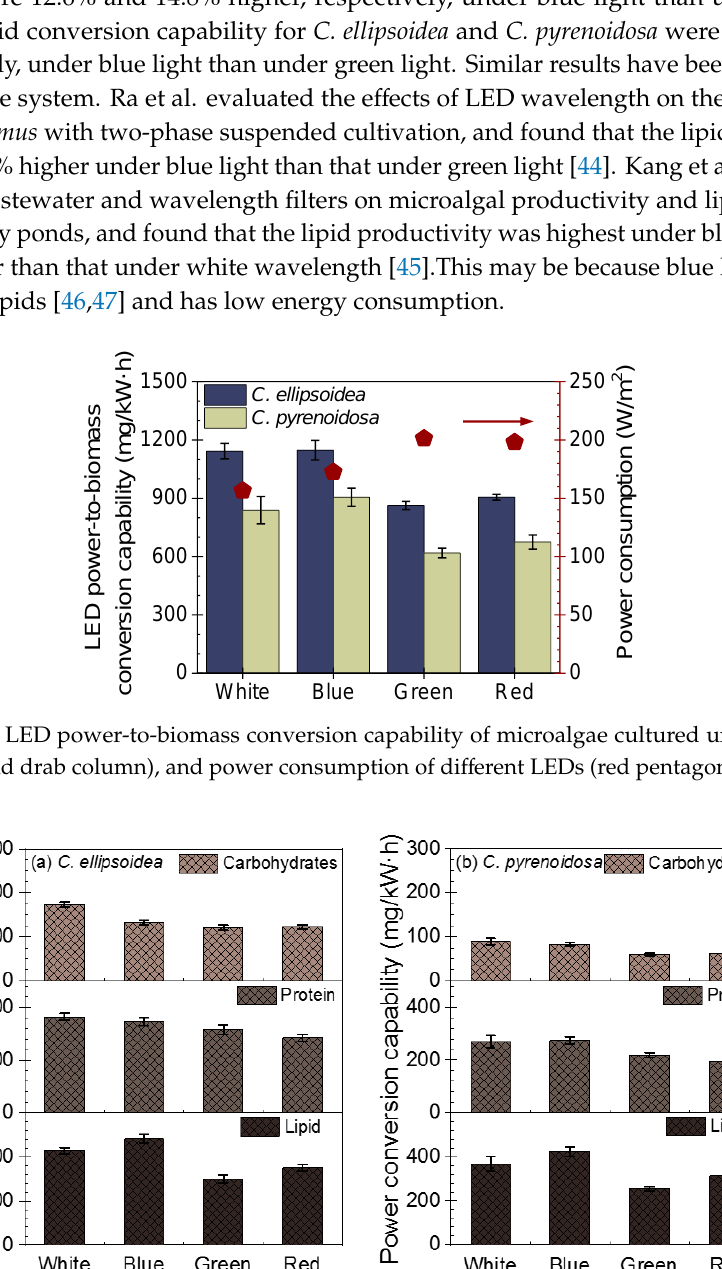
180 Figure 4. The LED power-to-biomass conversion capability of microalgae cultured under different 181 LEDs (blue and drab column), and power consumption of different LEDs (red pentagon ).